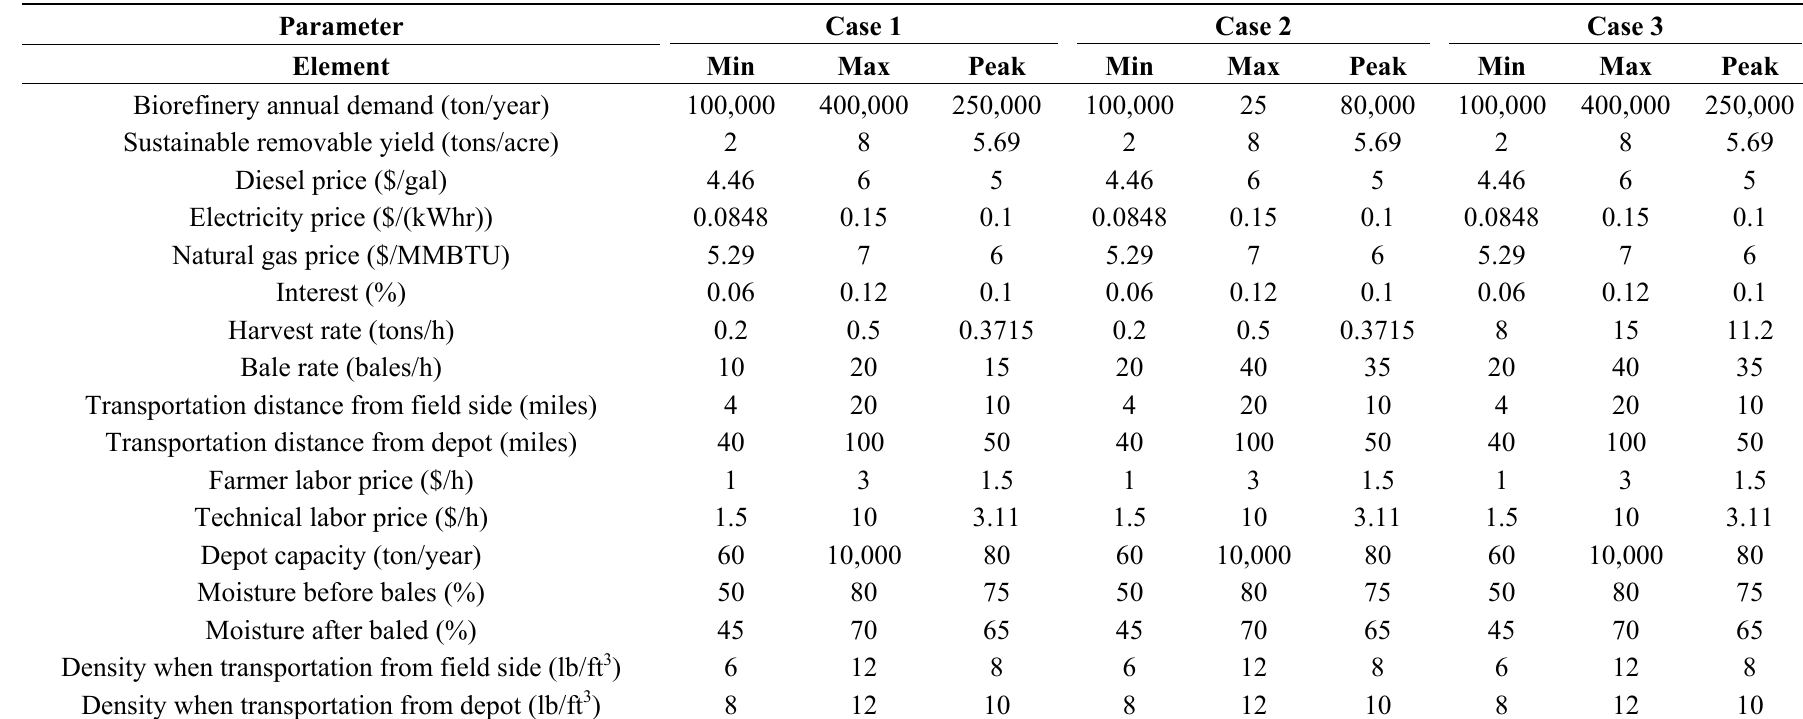
Table 4. Parameters and distribution variables chosen for sensitivity analysis of sweet